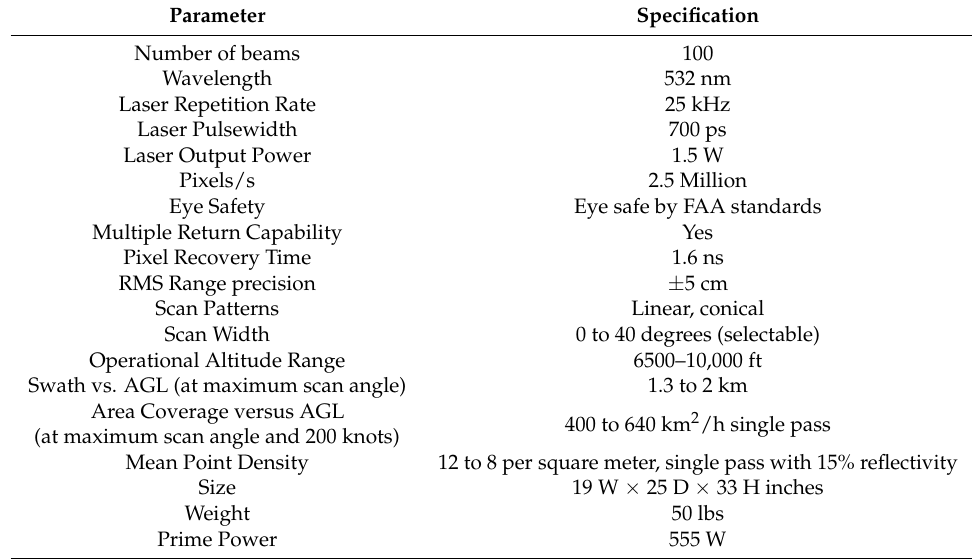
Table 1. Technical specifications for the HRQLS